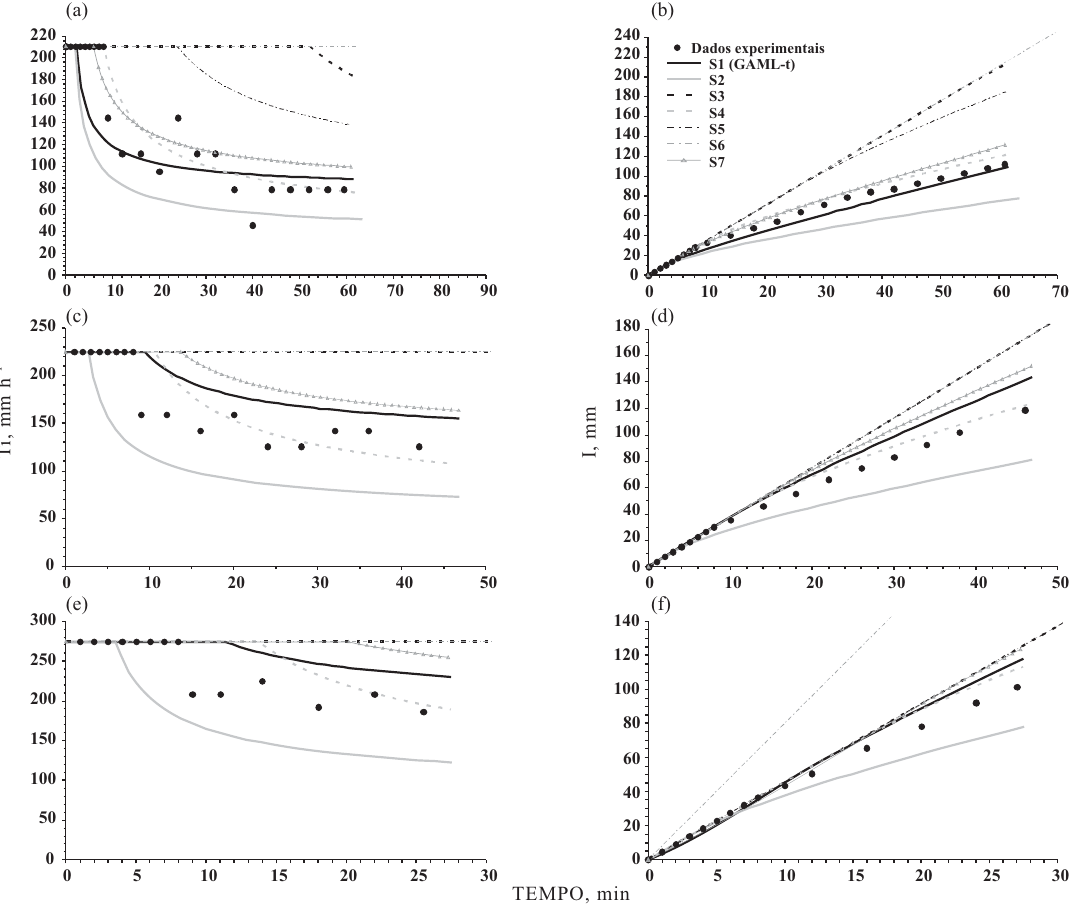
Figura 2. Taxas de infiltração (a), (c) e (e) e lâminas infiltradas (b), (d) e (f) medidas e estimadas para os três testes experimentais realizados no